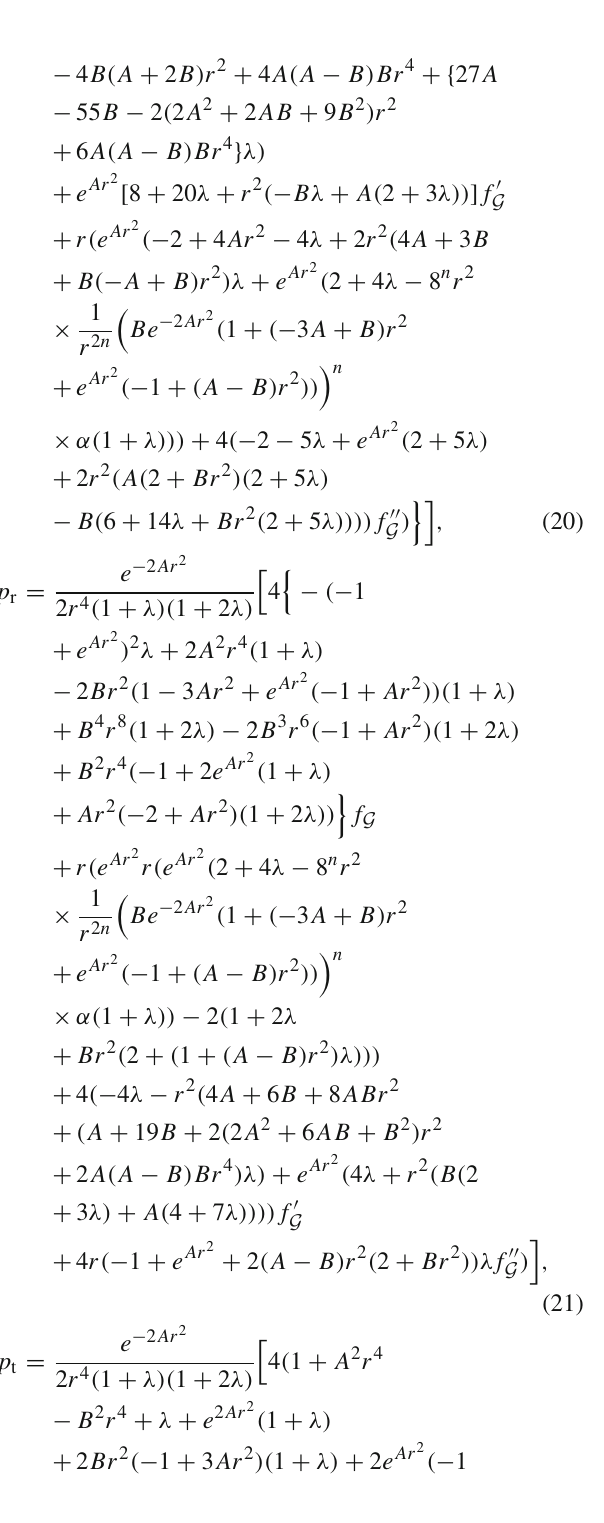
values of the masses M , radii R , compactness μ , and the constants A , and B for the compact stars Her X-1, SAXJ 1808.4-3658, and 4U